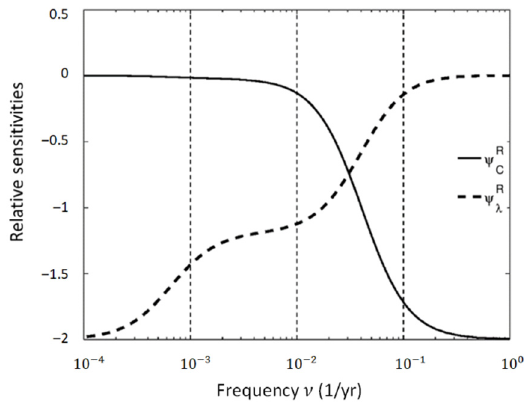
Figure 4. Power spectra of the global mean surface temperature fluctuations that were obtained from the two-box random energy balance model for different values of the feedback coefficient f . The dashed line shows the characteristic 1 𝜈 (cid:2870) ⁄ slope.